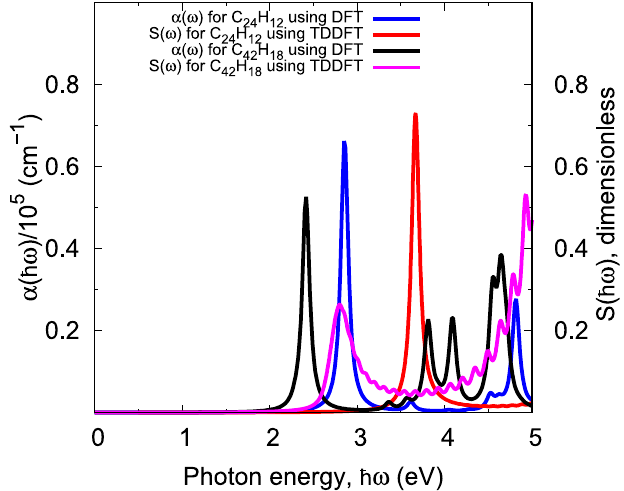
Figure 8. Absorption spectra of the HexC 24 zzH 12 and HexC 42 acH 18 monolayer GQDs calculated by two computational models: (i) standard DFT calculations using independent electron approximation via the permittivity tensor method and (ii) the many-body effects model using TDDFT as a linear response regime.